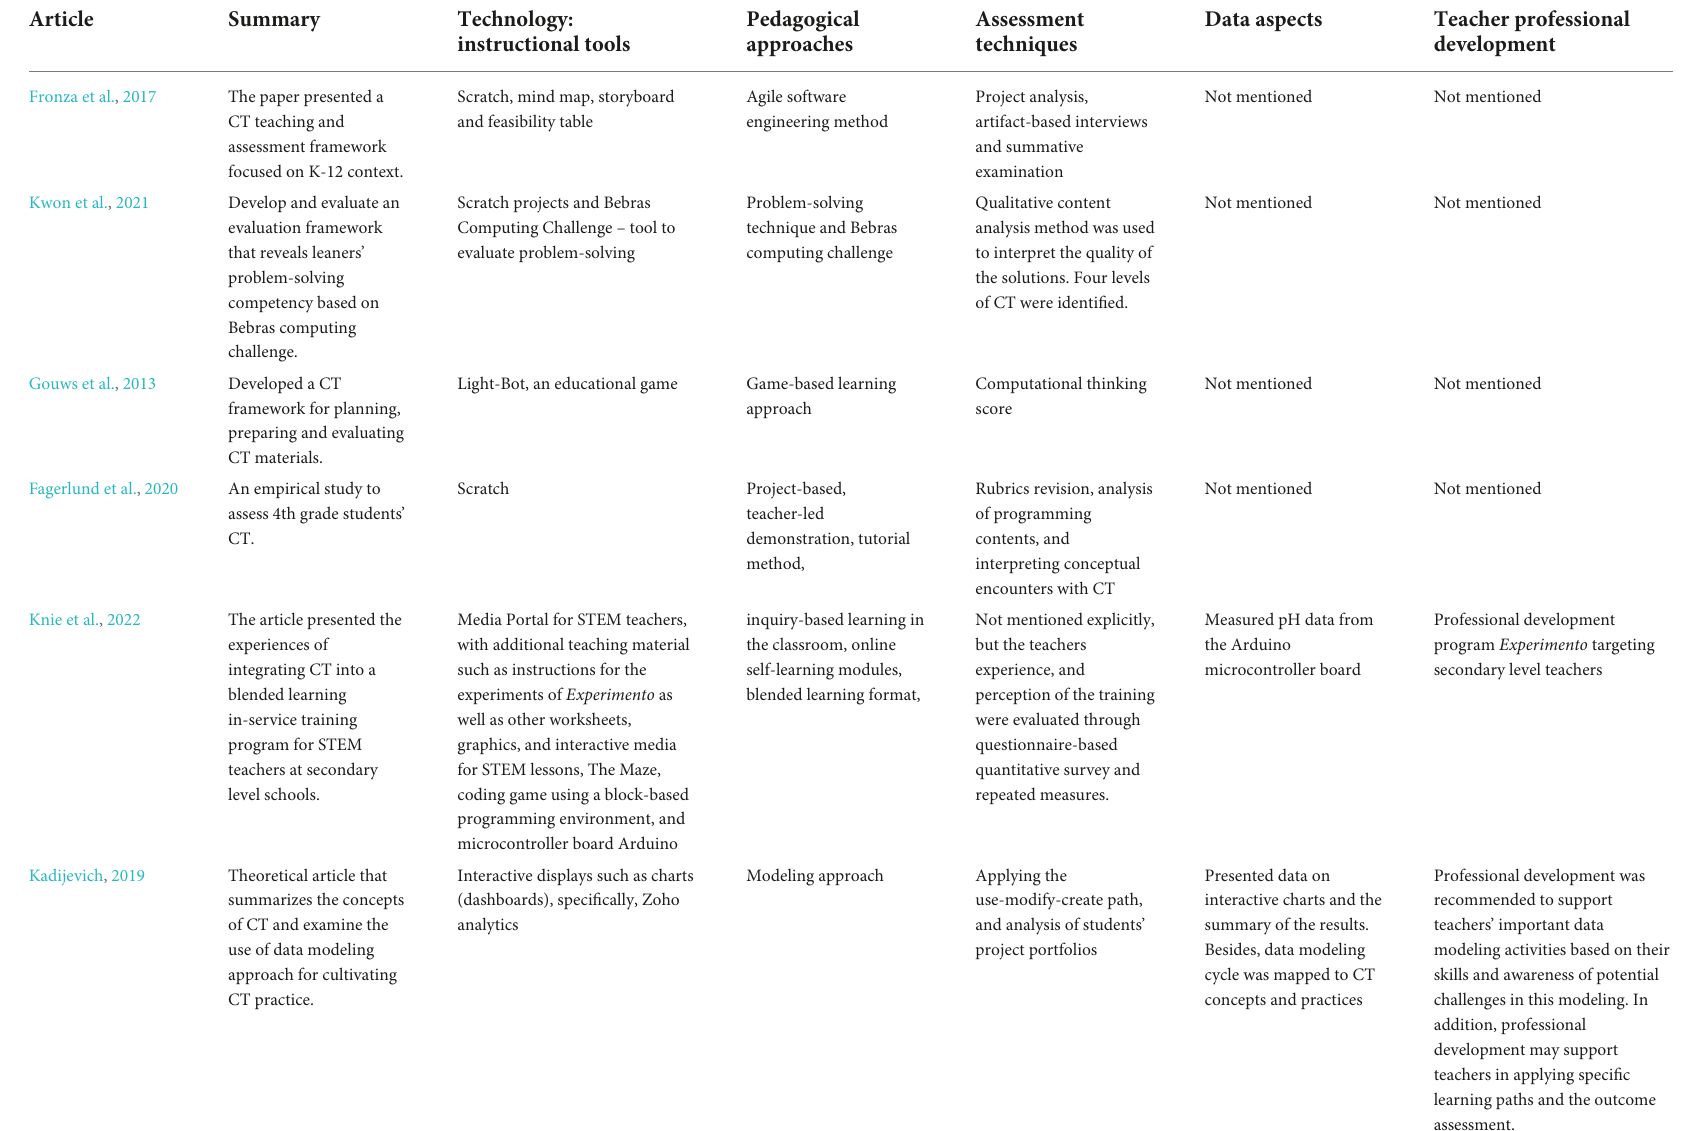
TABLE 2 Summary of articles according to indicators in